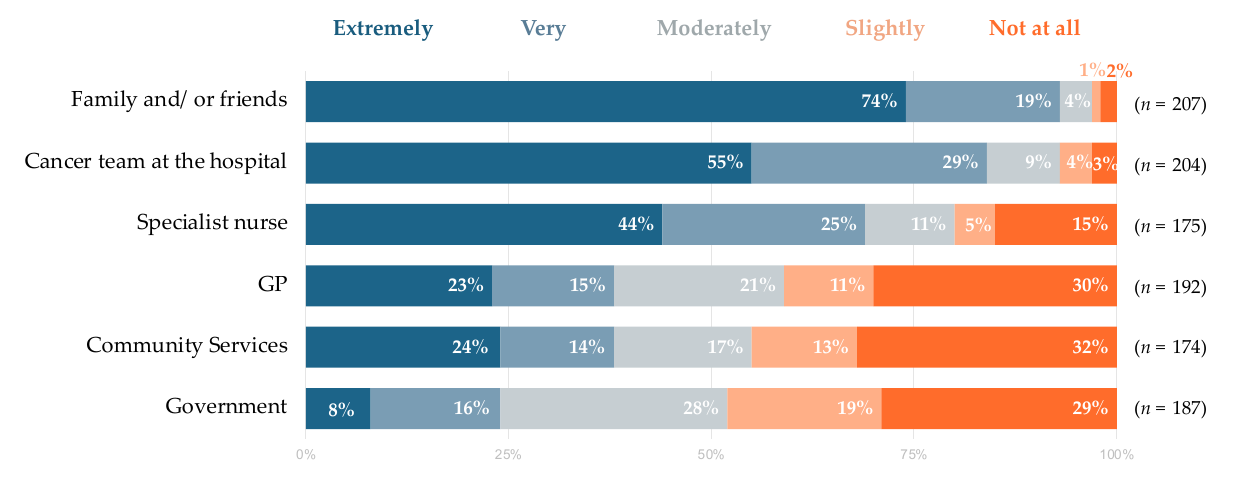
Figure 3. Figure 3. Perception of levels of support participants felt they had received during the COVID-19 pandemic.